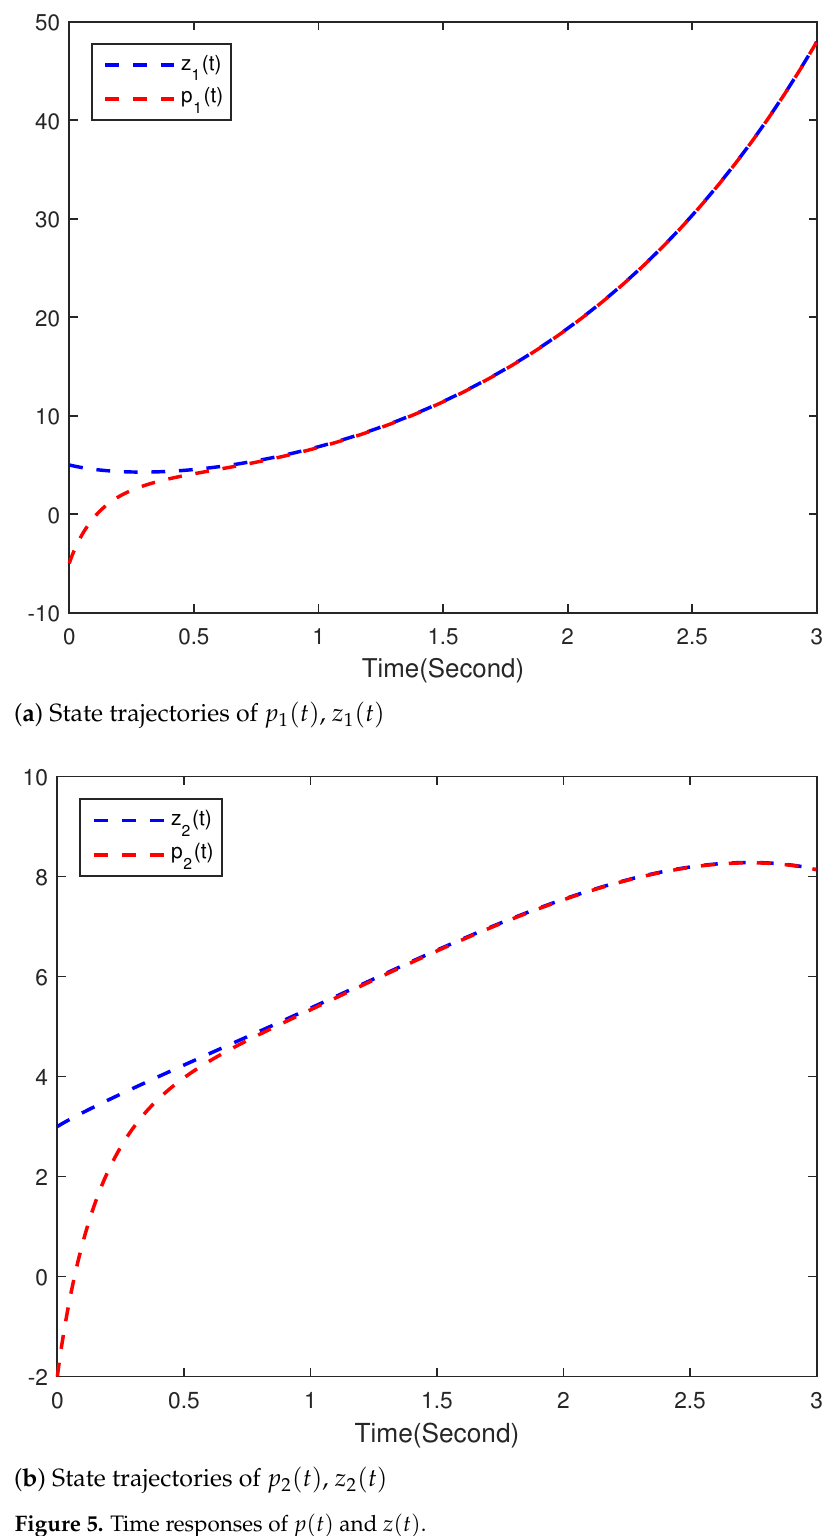
Figure 5. Time responses of p ( t ) and z ( t )